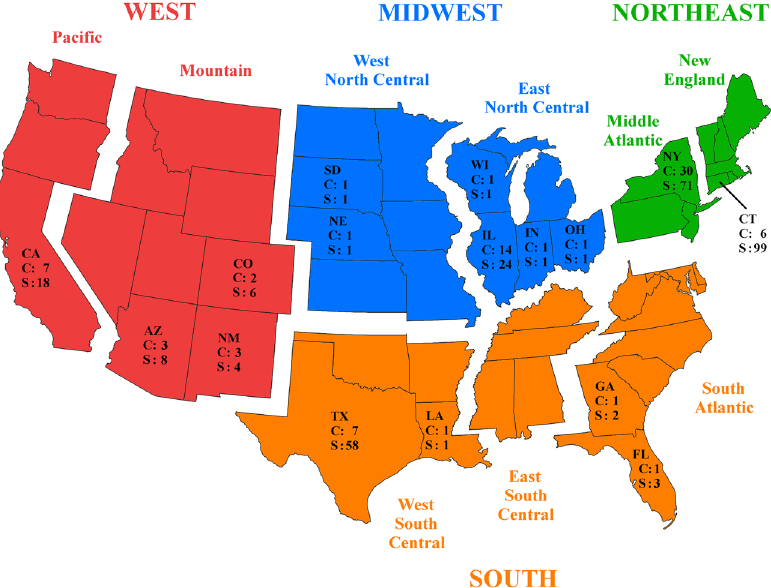
Figure 5. Visualization of the discrete state partitions. The four colors represent the discrete locations for the CBR model, which are further discretized into nine CBS locations, 16 states, and 80 counties. No samples were available for the East South Central subdivision at the CBS level. Each state is annotated with its number of unique sampled counties (C) and number of sequences (S). The Midwest, Northeast, South, and West regional models are county-level aggregations encapsulated by the K counties in their respective CBR. We utilized a blank map of the U.S. from ArcMap v10.3 and created the figure using GIMP v2.8 38